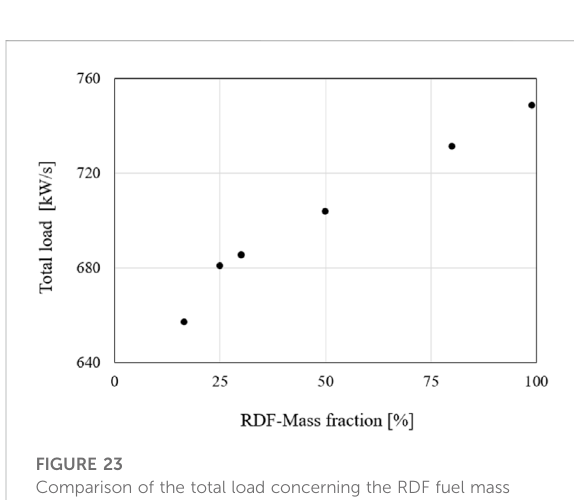
FIGURE 23 Comparison of the total load concerning the RDF fuel mass